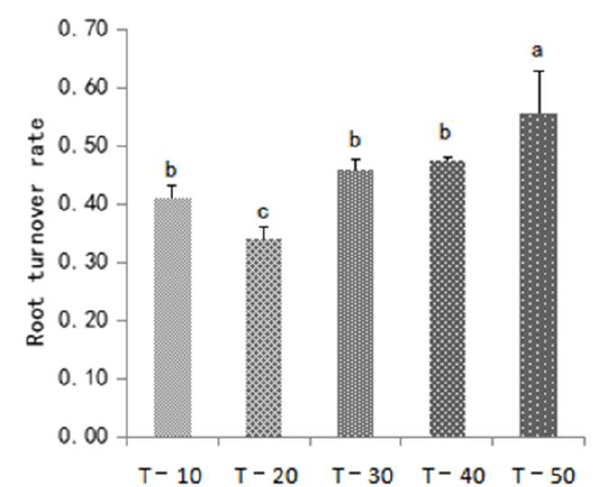
Figure 3. Effect of dwarfing interstock length on root turnover rate. Lowercase letters indicate significant differences between treatments ( p < 0.05).